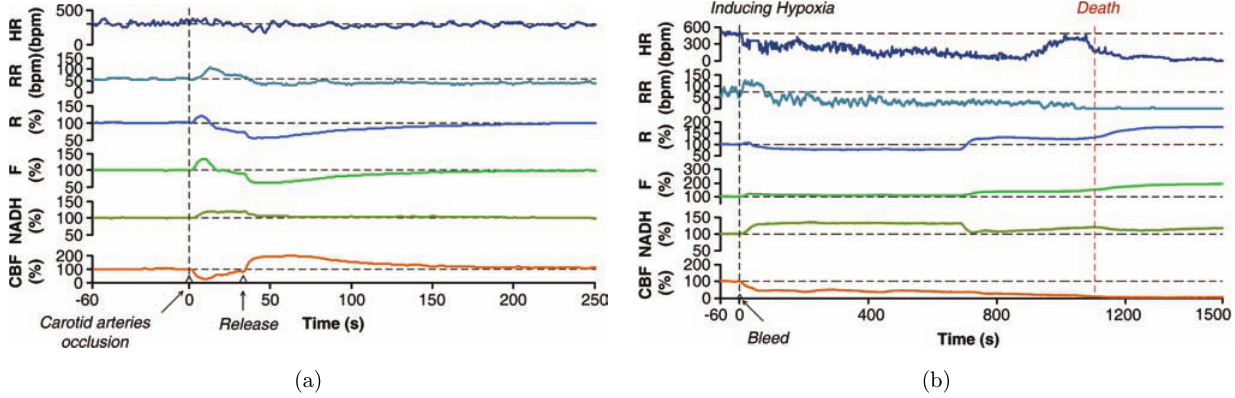
Fig. 3. Typical demonstrations of multiparametric monitoring during the procedure of circulatory hypoxia in (a) a rescued rat and (b) a rat died in the end.